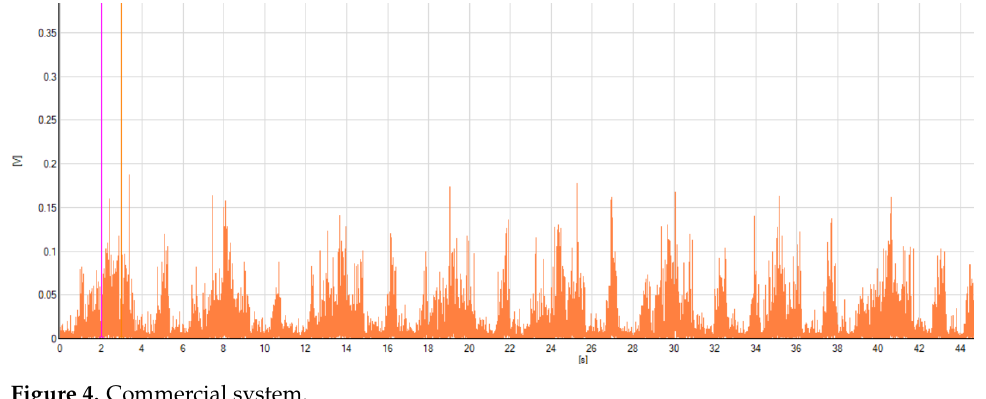
Figure 4. Commercial system.